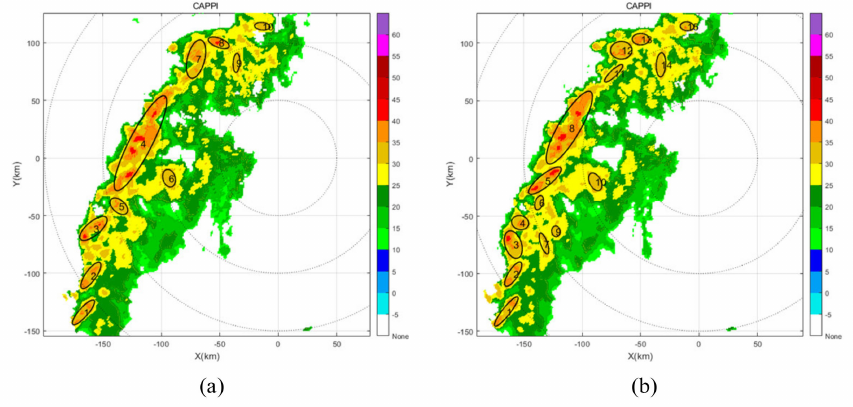
Figure 11. ( a ) TITAN algorithm recognition result at t3 and ( b ) TITAN algorithm recognition result at